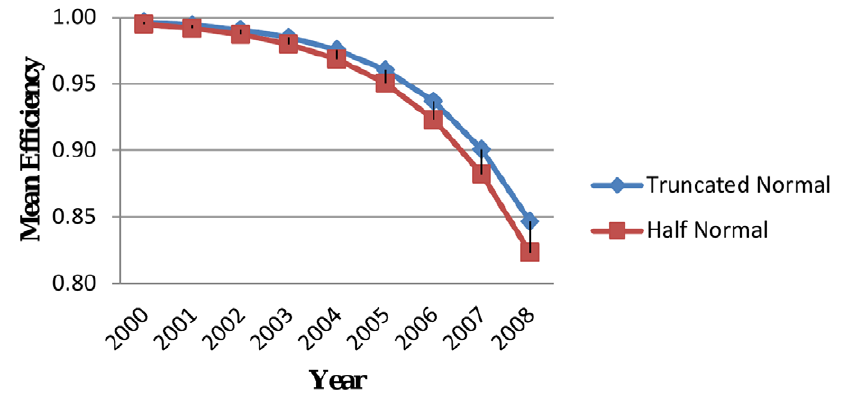
Figure 1. Year-wise mean efficiency by distribution.